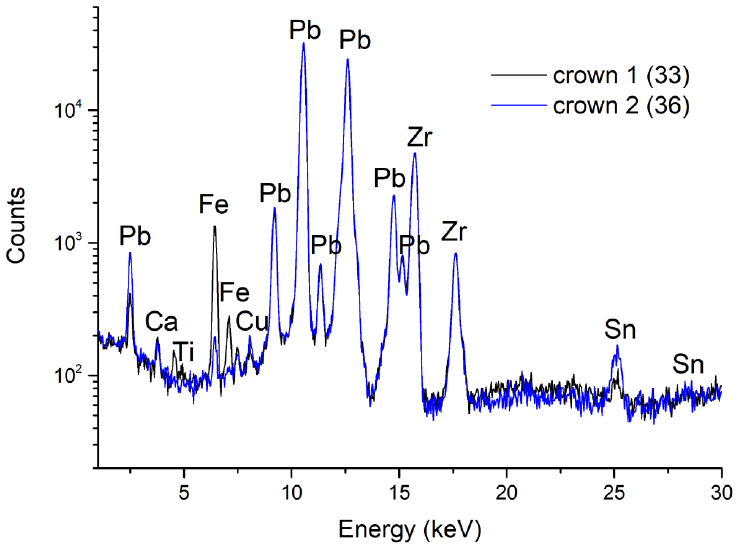
Figure 7. Comparison of XRF spectra of the crown. The basic yellow pigment applied is yellow earth (Fe) observed with black line, while highlights are carried out with lead – tin yellow (Pb, Sn) shown with blue line.